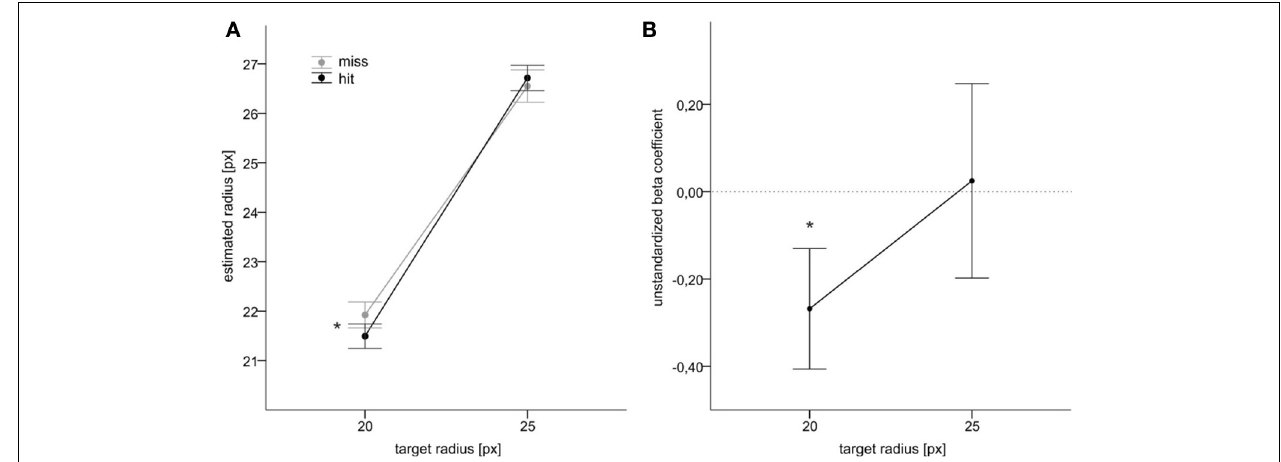
FIGURE 4 | Main results of Experiment 2. (A) Mean judgments of target radius as a function of target size and of action success. (B) Mean unstandardized beta coefficients for both targets. Error bars reflect standard errors. Asterisks denote statistical significance ( p ≤ 0 . 05).